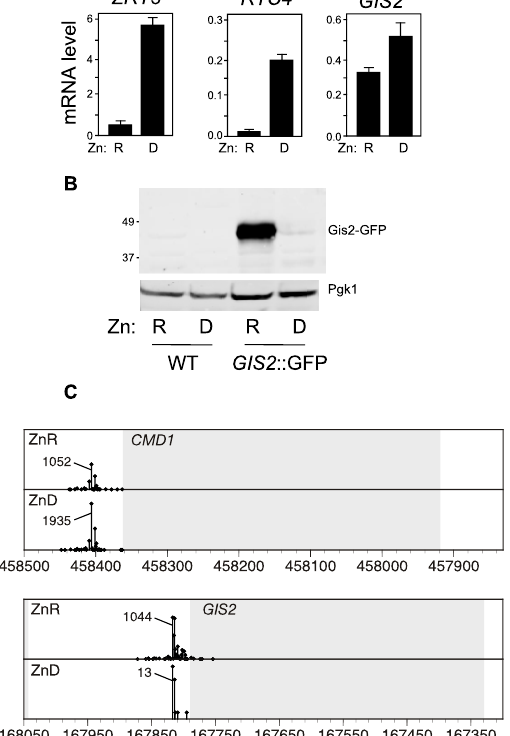
Figure 1. Effect of zinc status on GIS2 mRNA and protein levels. ( A ) real time polymerase chain reaction (RT-PCR) analysis of wild-type cells (BY4741) grown in either zinc-replete (R, low zinc medium (LZM) + 100 µM ZnCl 2 ) or deficient (D, LZM + 1 µM ZnCl 2 ) media. The data are the means of three biological replicates and the error bars indicate ± 1 SD. All changes in response to zinc status were found to be statistically significant with p-values of 0.004, 0.007, and 0.035 for ZRT3 , RTC4 , and GIS2 , respectively. ( B ) Immunoblot analysis of wild-type (BY4741) and BY4741 GIS2 ::green flourecent protein (GFP) cells grown under the same conditions. Anti-GFP and anti-Pgk1 antibodies were used for protein detection. The location of size markers is indicated on the left side in kDa. ( C ) Transcription start sites mapped by Deep-RACE for CMD1 and GIS2 under zinc-replete (ZnR) and zinc-deficient (ZnD) growth conditions are shown relative to each gene’s protein -coding region (shaded in gray ). Independent sequencing reads representing mRNA 5′ ends are plotted across each region. The x -axis coordinates represent the position on the corresponding chromosomes. Peak values of the number of sequence reads for each gene and growth condition are shown. The transcription start site mapping data are from Wu et al. [25].